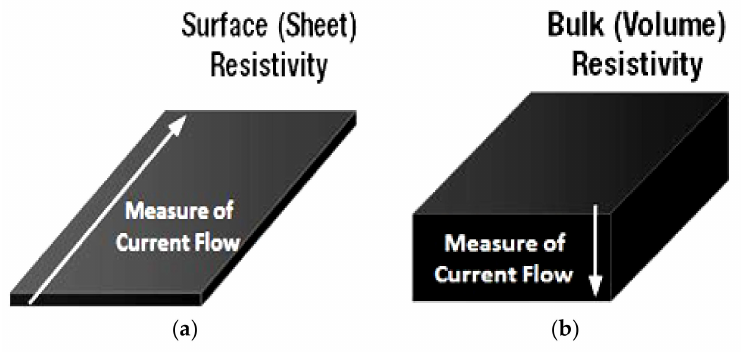
Figure 11. Volume resistivity ( a ) and surface resistivity ( b